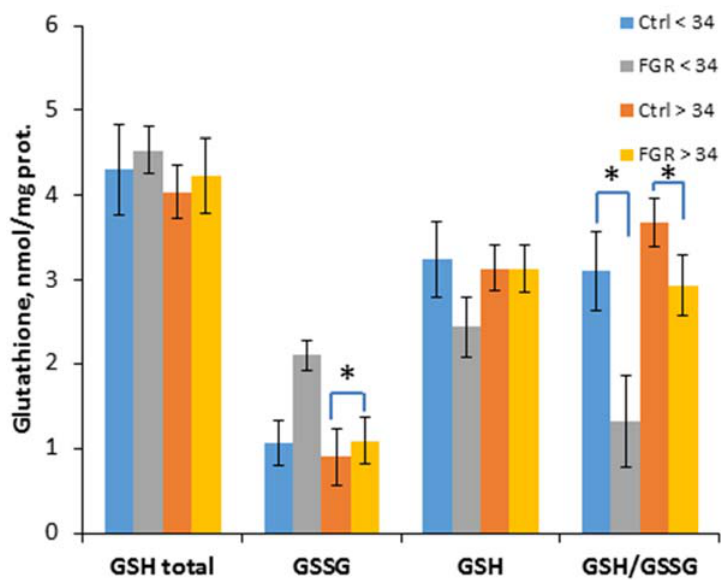
Figure 3. The content of glutathione (total GSH), its reduced (GSH) and oxidized (GSSG) forms, as well as their ratio in the umbilical cord blood plasma of the newborns. Data are presented as mean ± SD; *: significance level p ≤ 0.05 (p-adjusted) when compared with the control group of the corresponding gestational age.. Ctrl <> 34 are the control groups of the corresponding gestational age. FGR <> 34 are the groups with FGR corresponding to gestational age.